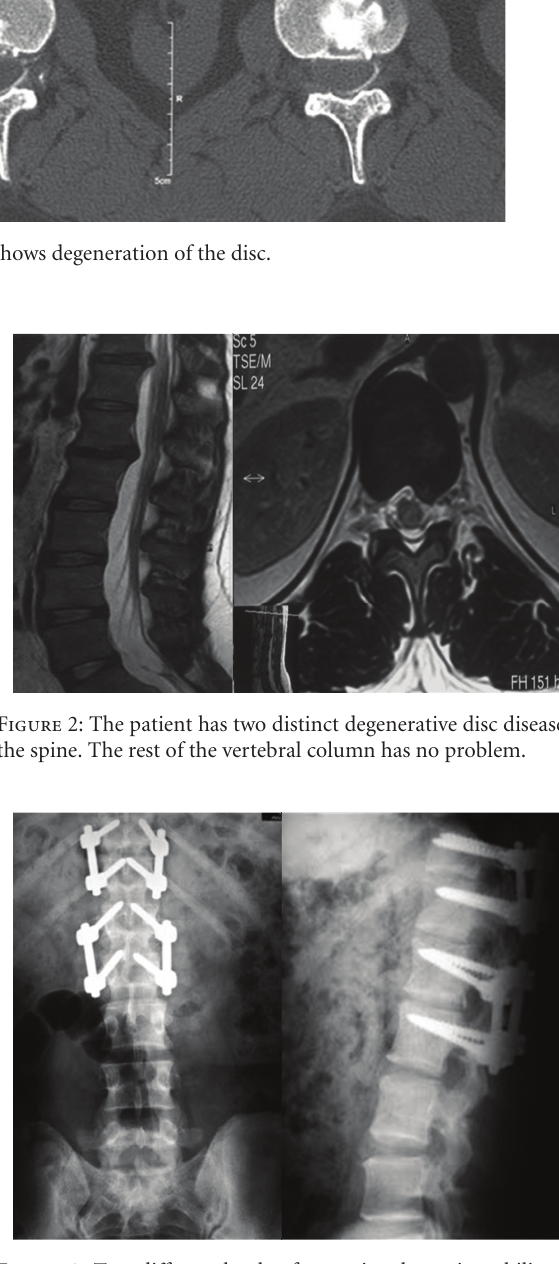
Figure 3: Two di ff erent levels of posterior dynamic stabilizations were performed in the same